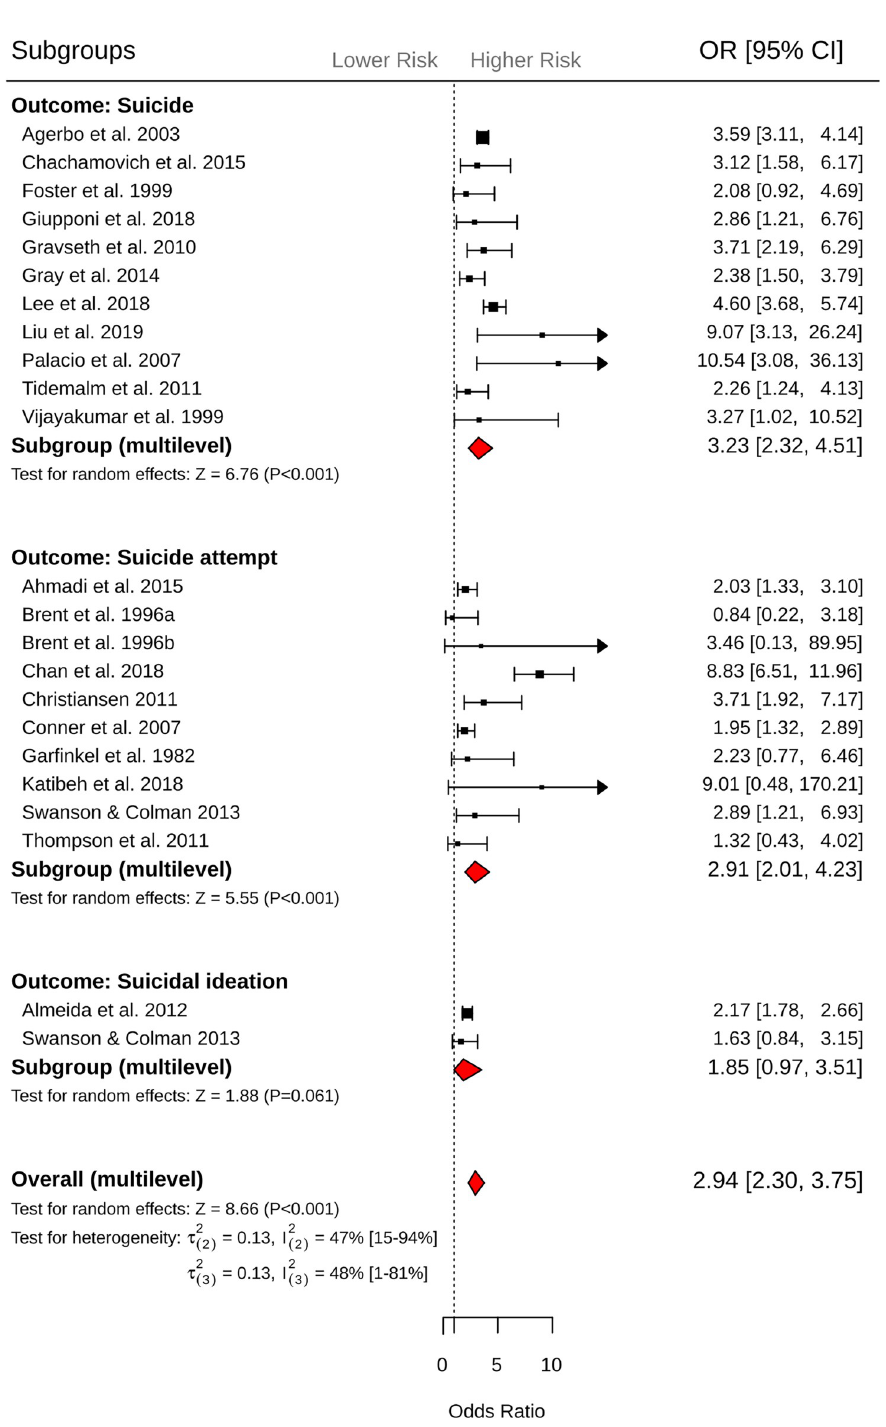
Fig 2. Forest plots of exposure to suicide and subsequent suicide, suicide attempt, and suicidal ideation outcomes. CI, confidence interval; OR, odds ratio.